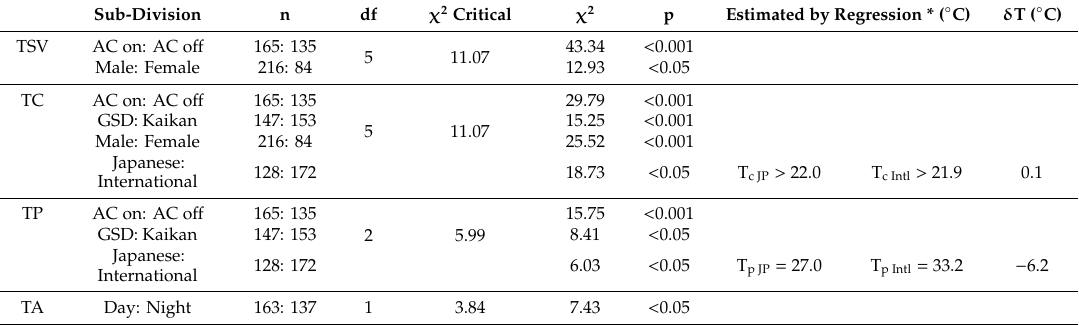
Table 7. Summary of Chi-square results: Dependence of TSV, TC, TP and TA on